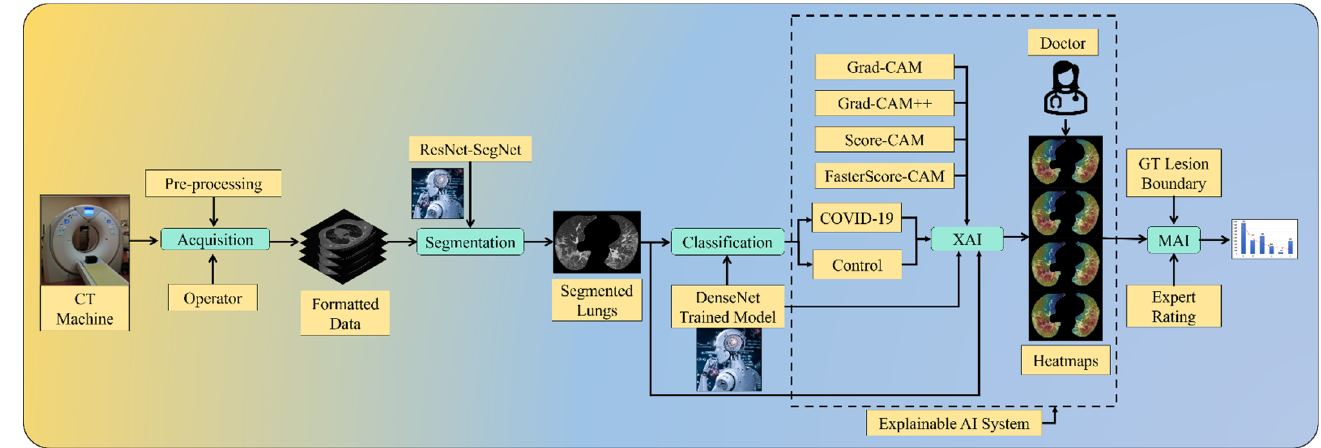
Figure 1. COVLIAS 2.0-cXAI